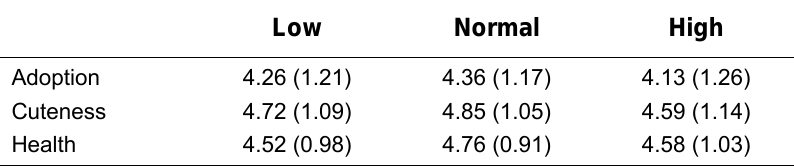
Means and SD for High, Normal, and Low Body Weight Faces (n = 63)